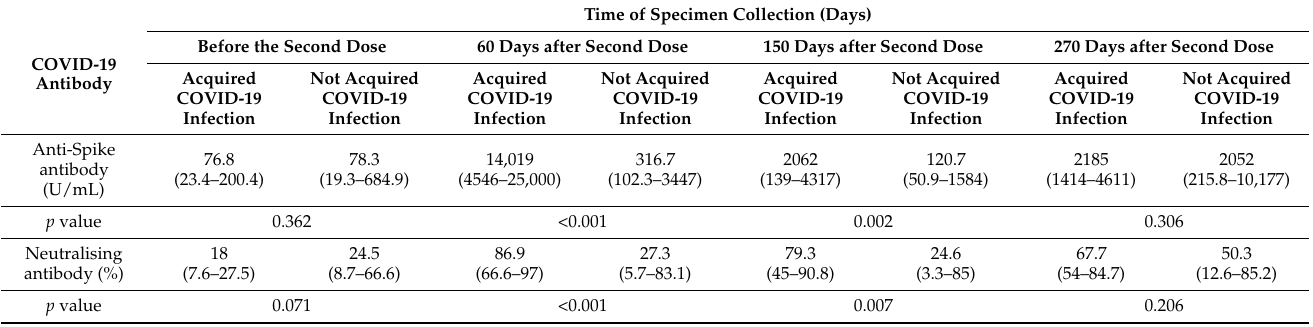
Table 4. Comparison of COVID-19 antibody response between the participants who acquired COVID-19 infection ( n = 29) or not ( n = 106) after the second dose of vaccine ( n = 135) in overall